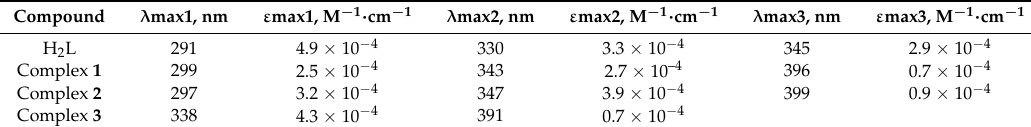
Figure 2. The UV-VIS spectra of H 2 L and its complexes 1 , 2 and 3 (cm − 1 ). Table 3. Absorption maxima and molar extinction coefficients for H 2 L and its complexes 1 , 2 and 3 .